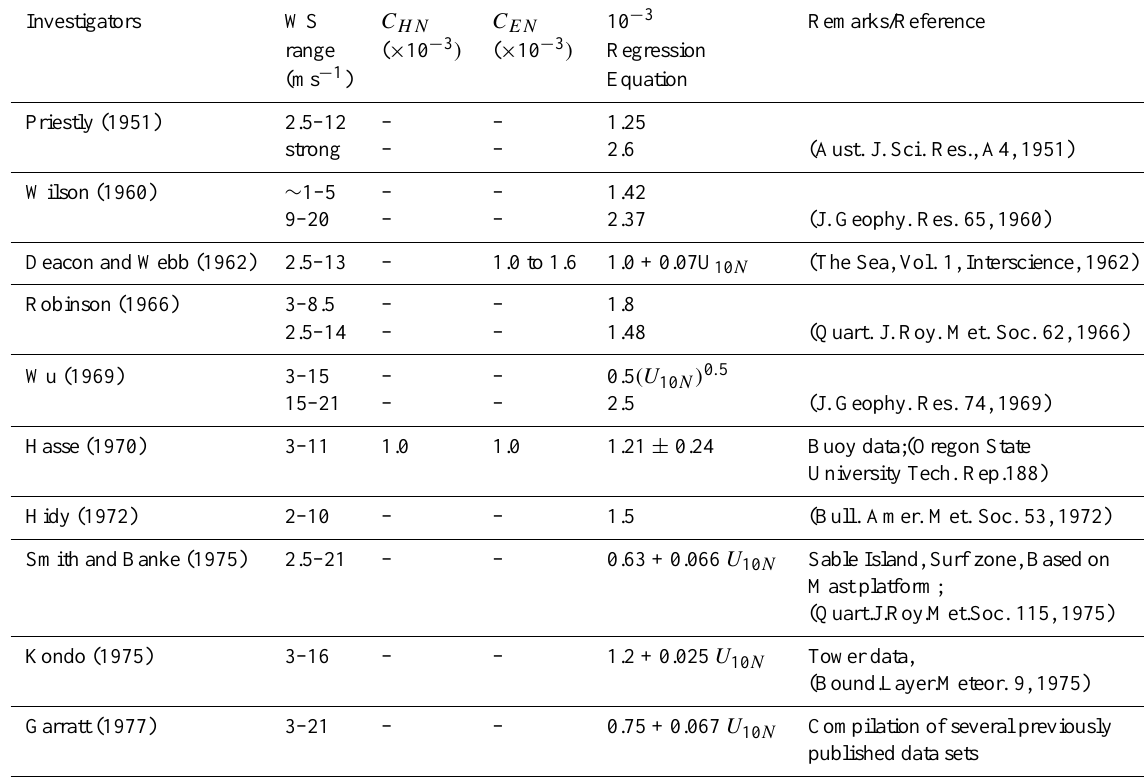
Table 2. Review on comparison of estimates in air-sea exchange coefficients ( C H and C E ) and regression of drag coefficient for neutral stratification ( C DN ) based on wind speed at